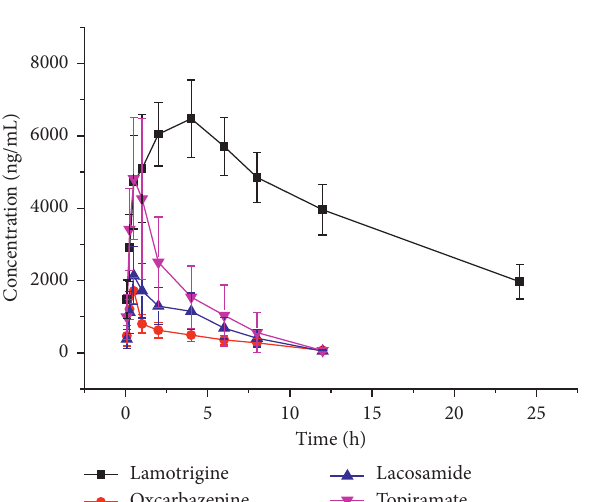
Figure 4: Plasma concentration-time curves of lamotrigine, oxcarbazepine, lacosamide, and topiramate in rats after oral administration. Table 4: Pharmacokinetic parameters of lamotrigine, oxcarbazepine, lacosamide, and topiramate after oral administration in rats. Parameters Unit